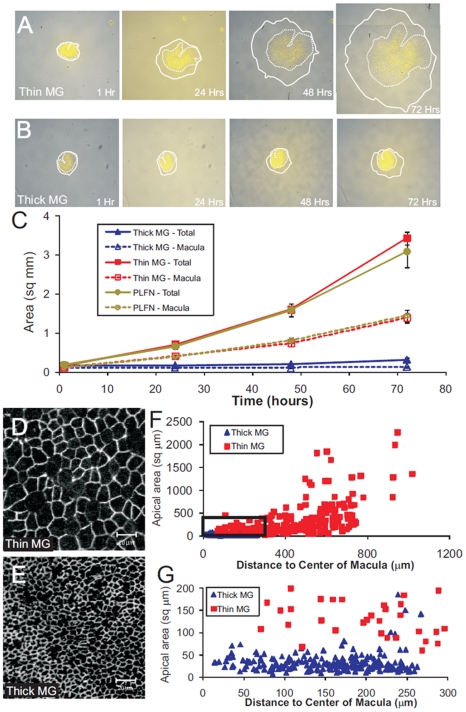
Maculae from E18 mouse utricles spread on thin layers of Matrigel, but spread little on thick droplets of Matrigel.(A) A delaminated utricular epithelium from an E18 mouse utricle cultured on a thin layer of Matrigel (thin MG) shows significant spreading of both the macula (demarcated by the dashed line) and the non-sensory epithelium (tissue between dashed and solid line) over 72 hours in culture. To distinguish the macula from the non-sensory epithelium, hair cells were selectively labeled with the styryl dye, FM1–43 (yellow; [55]). (B) A delaminated utricular epithelium from an E18 mouse utricle cultured on a thick droplet of Matrigel (thick MG) shows little spreading of the macula over 72 hours in culture, though there was spreading of the non-sensory epithelium. (C) The mean total area of the explanted utricular epithelium (solid line) and macula (dashed line) are plotted at each time point for epithelia from E18/19 mouse utricles plated on thick MG, thin MG, or a coverglass coated with poly-lysine and fibronectin (PLFN). (D–E) Confocal images taken near the center of the macula from an E18 mouse utricular epithelium cultured on thin MG (D) or thick MG (E) for 72 hours, and immunostained with antibodies to the tight junctional protein, occludin, to label apical borders of supporting cells. (F) Quantification of the apical area of 210 cells from a single epithelium cultured for 72 hours on thick MG (blue triangle) and 175 cells from a single epithelium cultured on thin MG (red square). Cells grown on thin MG have a significantly larger mean apical area than cells grown on thick MG (384.0±29.7 µm2 versus 32.6±1.5 µm2; p<0.05, Student's t-test). (G) Magnification of the boxed region in (F) showing that even at the center of the macula, cells cultured on thin MG have an enlarged apical area compared to cells cultured on thick MG.